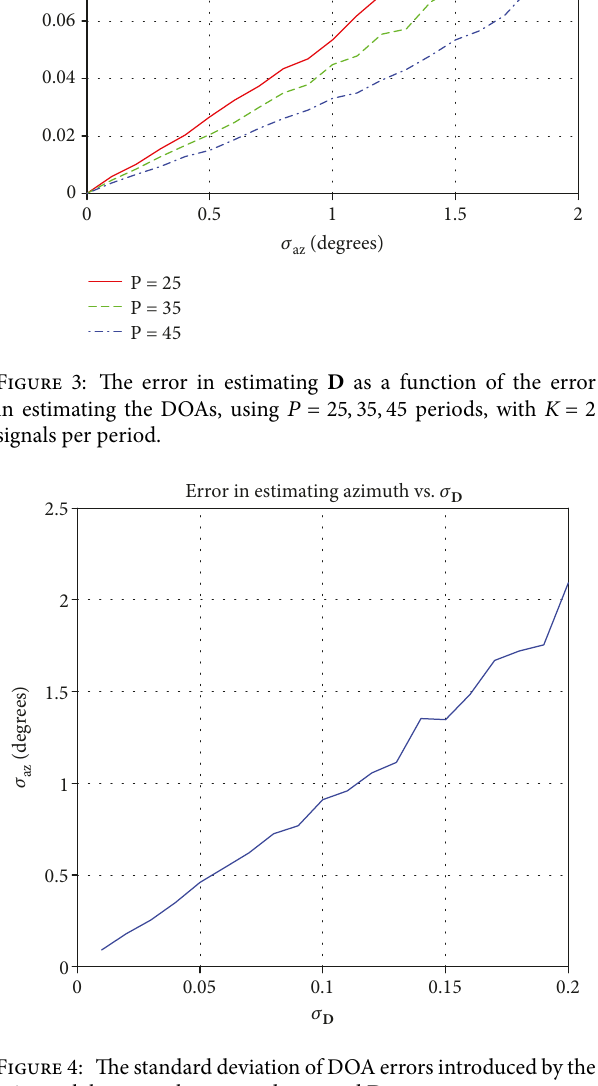
Figure 4: The standard deviation of DOA errors introduced by the mismatch between the true and assumed D